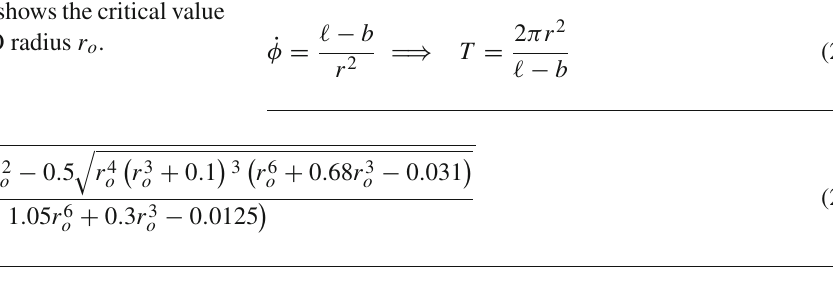
the easy escape of the particle from the BH surrounding. b Shows the shift in ISCO position away from the BH horizon for large value of angular momentum L . The behavior of V eff against parameter η and a are presented in c and d , respectively Fig. 6 we show the critical behavior of magnetic field b and angular momentum L as a function of ISCO radius r o . So, for large r , b becomes constant but L is increasing see Fig. 6. For the weakly magnetized BH magnetic field strength decreases with the increase of distance. Panle (b) of Fig. 6 indicates that the large L can shift the ISCO position r o away from the